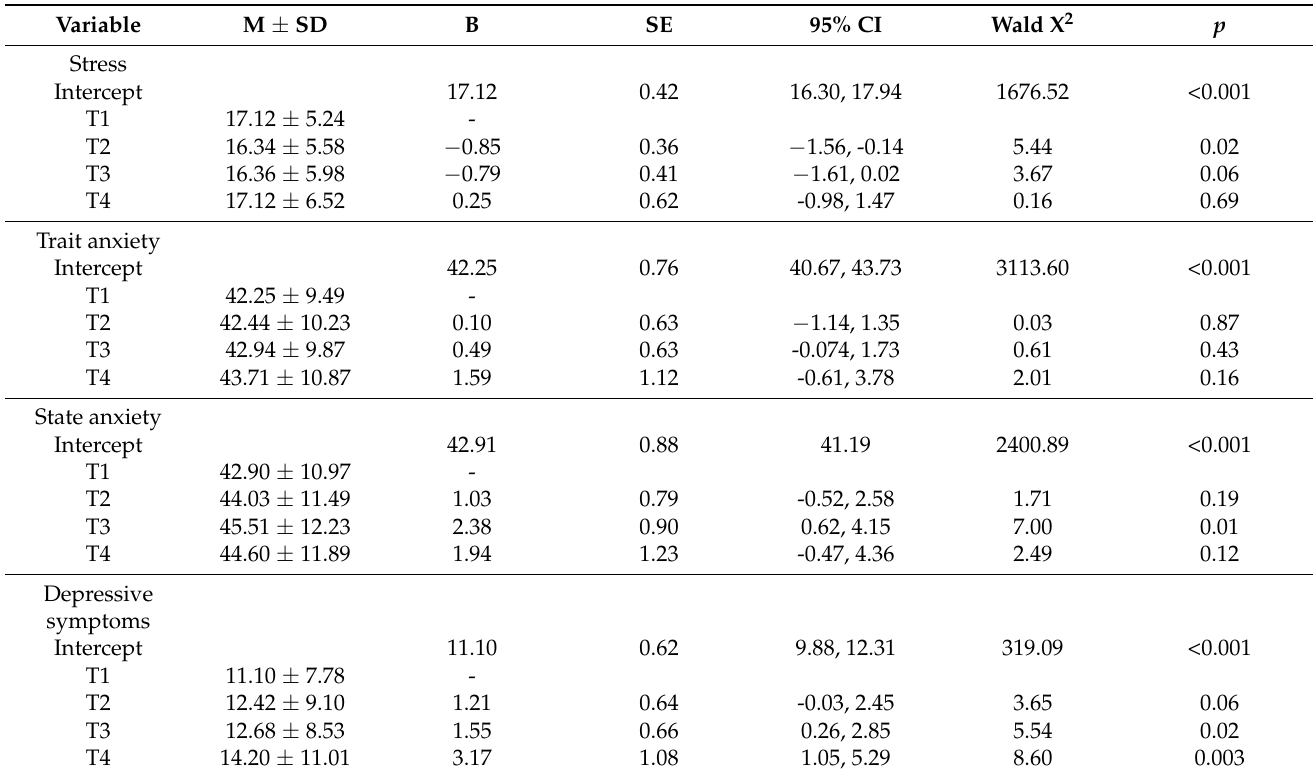
Table 2. Trends of stress, anxiety, and depressive symptoms from pregnancy to postpartum.